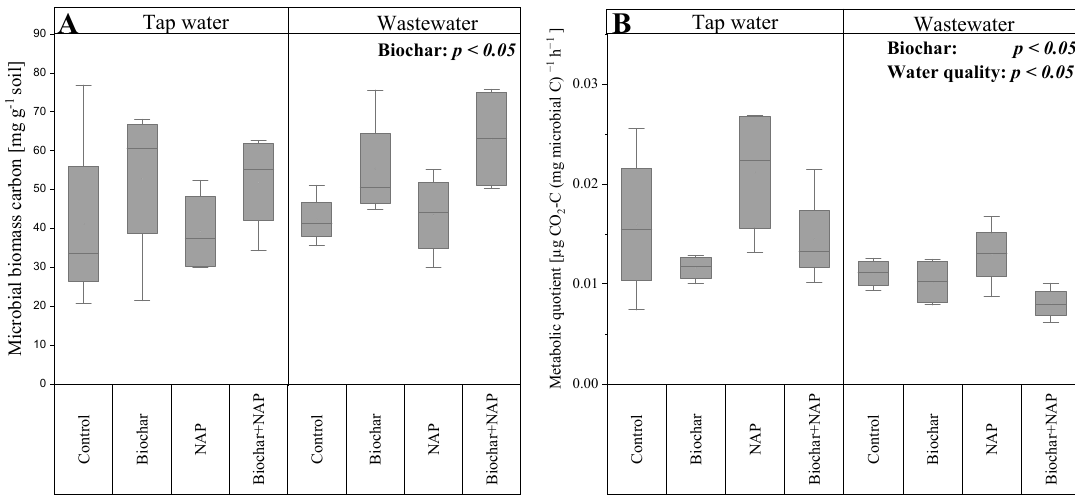
Figure 2. Microbial biomass carbon ( A ) and metabolic quotient ( B ) of soil. Whiskers on boxplots represent 95% and 25% percentile. Statistically significant effects of the treatments (biochar, fertilizer, water quality and interactions) from MANOVA ( p < 0.05) are indicated in the graphs.